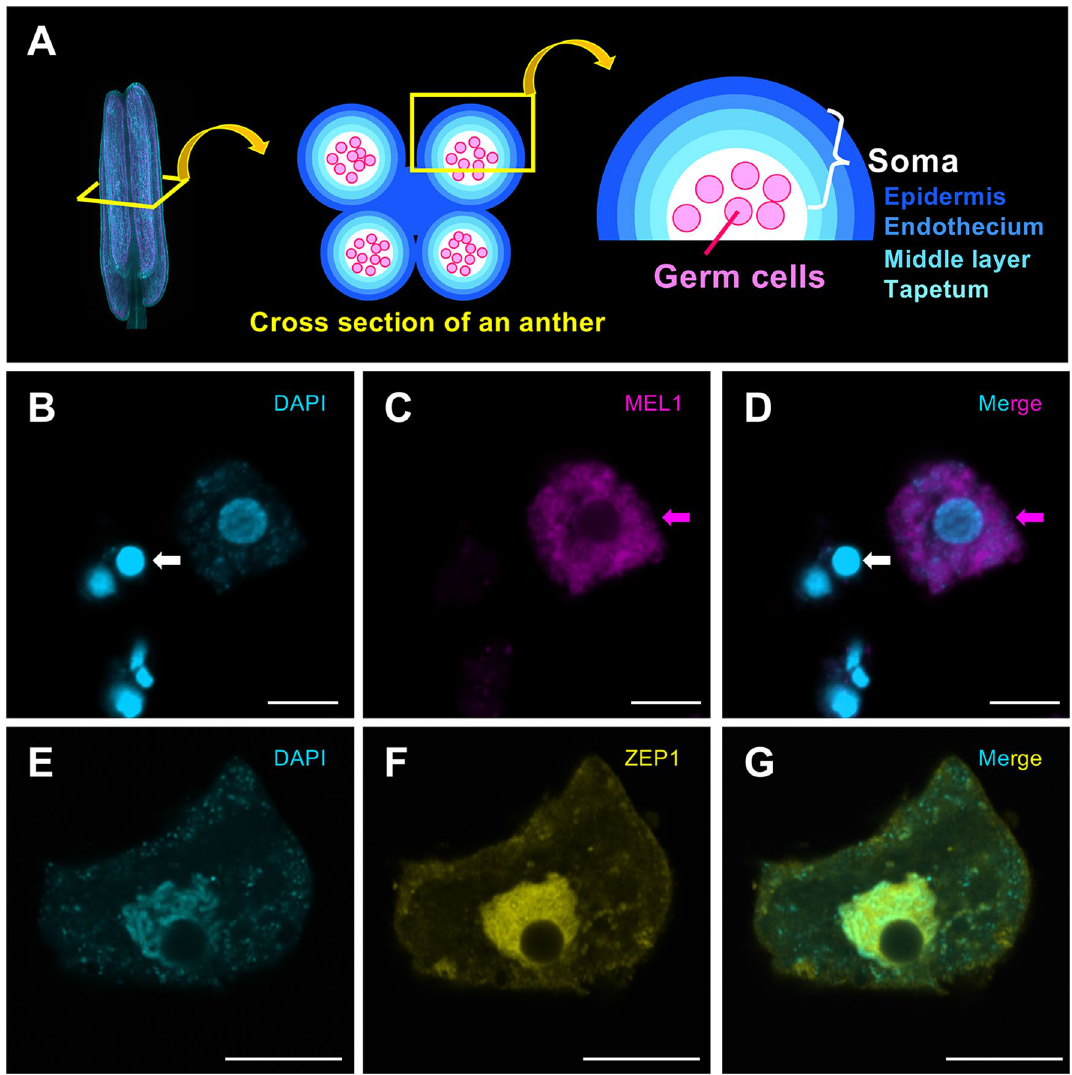
Figure 1. Immunostaining using pollen mother cells for anti-MEL1 and meiocytes for anti-ZEP1. ( A ) Schematic diagram of an anther. The image on the left shows an anther stained with SCRI Renaissance 2200. The anther consists of four locules (middle), and a cross-section of a single locule demonstrates the four somatic anther wall layers (right), including the epidermis (Ep), endothecium (En), middle layer (Ml), and tapetum (Ta), which enclose the germ cells. ( B – D ) MEL1 localization is restricted to the cytoplasm (magenta). White arrows indicate a single somatic cell from the anther wall, although its origin from a specific somatic cell type (Ep, En, Ml, or Ta) remains unknown. Magenta arrows indicate a pollen mother germ cell at the premeiotic stage. ( E – G ) Indirect fluorescence signals of ZEP1 are enriched on the meiotic chromosomes (yellow). Cyan signals indicate DAPI staining ( B and E ). Merged images of ( B ) and ( C ), and ( F ) and ( G ), respectively ( D and G ). Scale bars, 10